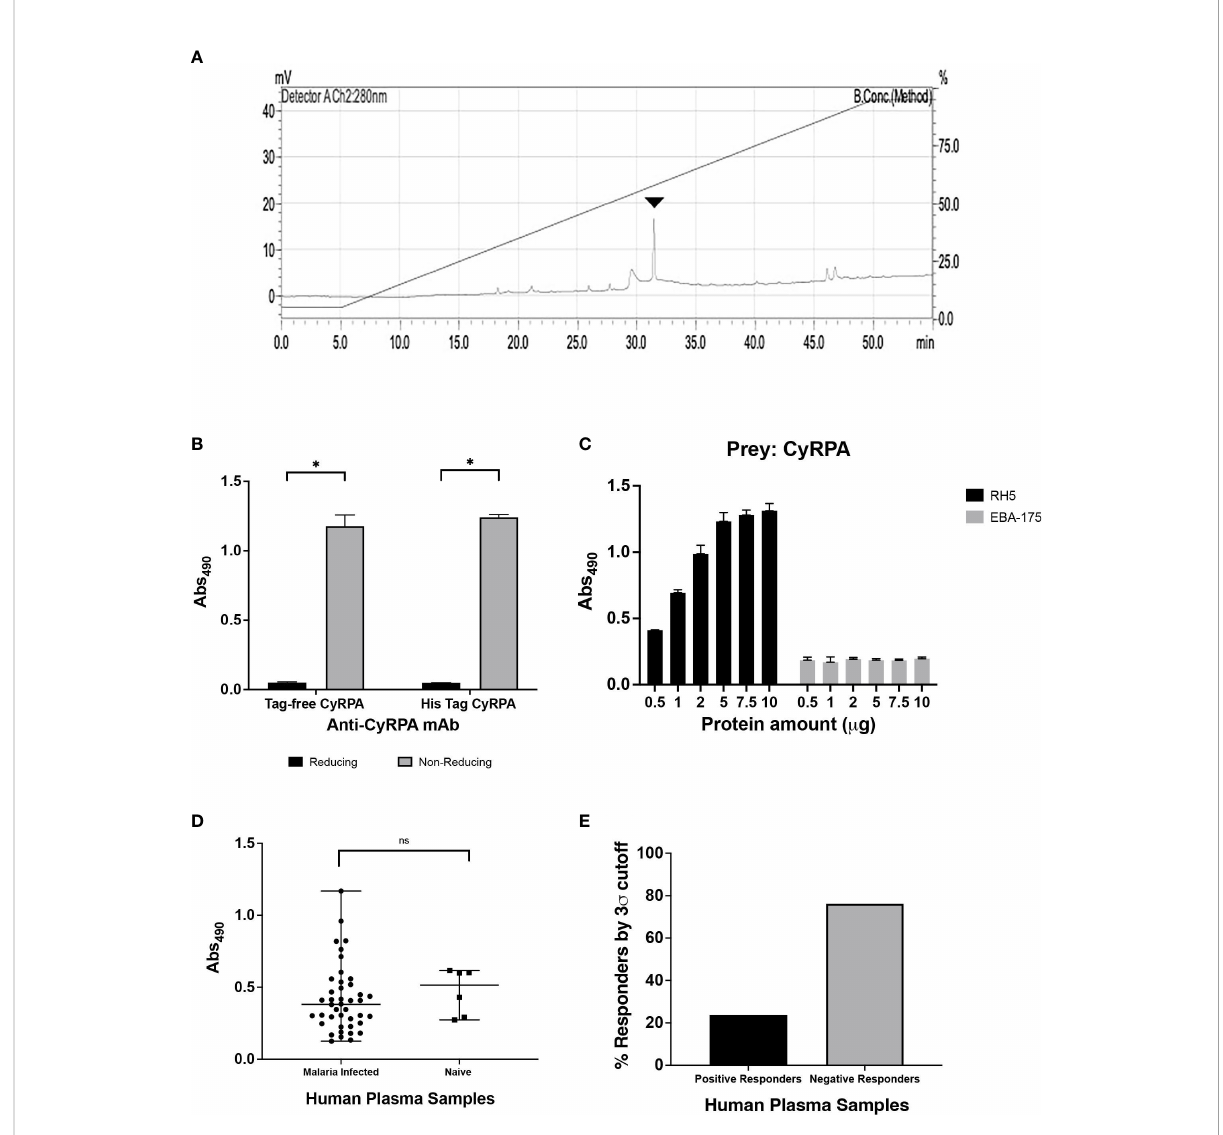
FIGURE 4 Structural and Functional Integrity of Recombinant Tag-free CyRPA. (A) Reverse Phase-High Performance Liquid Chromatography (RP-HPLC) analysis of the fi nal puri fi ed recombinant tag free CyRPA showed a symmetrical peak depicting homogeneous preparation of the protein with >90% purity. Arrowhead shows the peak. (B) Enzyme-linked immunosorbent assay (ELISA) of tag-free CyRPA and (6-His) tagged CyRPA using conformational CyRPA monoclonal antibody (c10) under reducing and non-reducing conditions depicts recognition of non-reduced recombinant proteins by the antibody. The bars and error bars show mean and standard error values respectively. The P values were calculated by unpaired t-tests. (C) ELISA based interaction study between puri fi ed tag-free CyRPA and RH5 was performed. RH5 (bait) and EBA-175 RIII-V (used as negative control) were coated and CyRPA (prey) was added at different concentrations (5 m g/ml to 100 m g/ml). The interaction intensity between CyRPA and RH5 increased with increase in CyRPA concentration, while no interaction was observed between CyRPA and EBA-175 RIII- V. The bars and error bars show mean and standard error values for each protein amount respectively. (D, E) Seropositivity of CyRPA was analyzed in plasma from 42 malaria-infected individuals obtained from a malaria endemic region, Balaghat (Madhya Pradesh, India) by ELISA. CyRPA exhibited detectable levels of antibodies with absolute ELISA values ranging from ~ 0.1 to 1.1 optical density (OD) units. Sera isolated from six malaria naïve individuals were used as controls and to calculate the cut-off value, which is the mean OD of control malaria-naive samples plus three times standard deviation. Graph shows median values and ranges. The P values were calculated by Mann-Whitney U test. (E) CyRPA was poorly immunogenic with <30% of the samples showing a positive response to the antigen. A sample with ELISA OD value above the cut-off was considered a positive responder, while samples with OD values below the cut-off were de fi ned as negative responders. mV, millivolt; Abs 490 , absorbance at 490 nm. *P ≤ 0.05; ns- non-signi fi